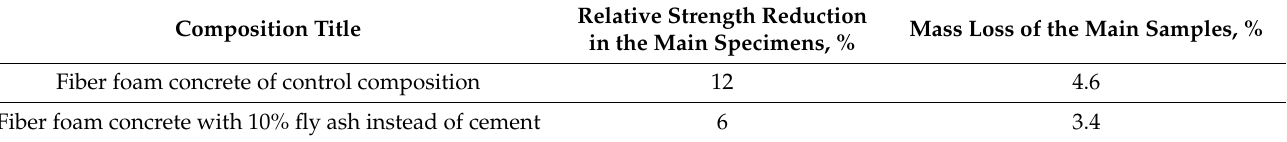
Table 14. Results of frost resistance assessment.